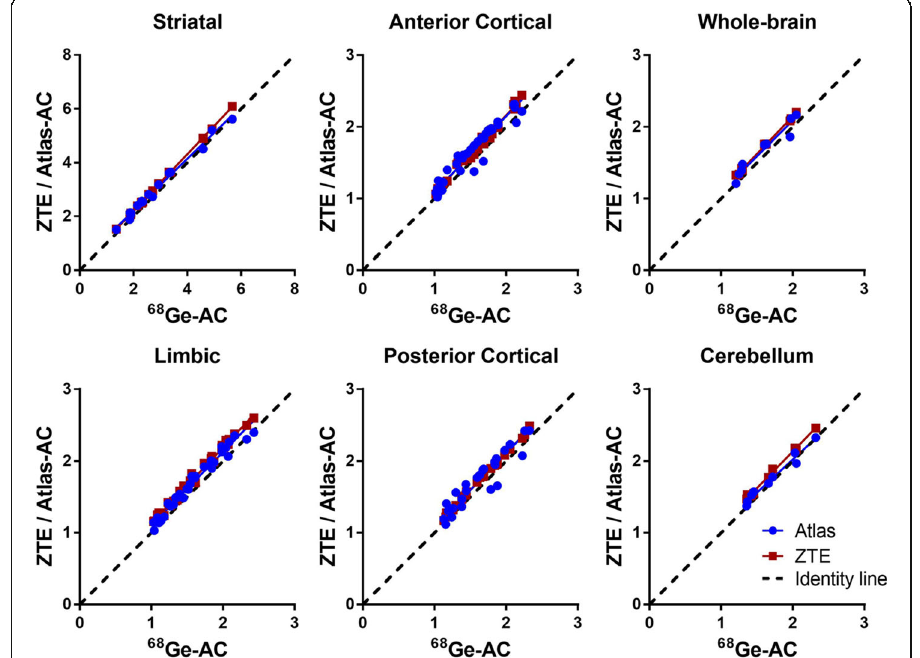
(AC; gold standard) and ZTE- or atlas-AC. Solid lines represent Deming regressions, and the dashed lines represent identity